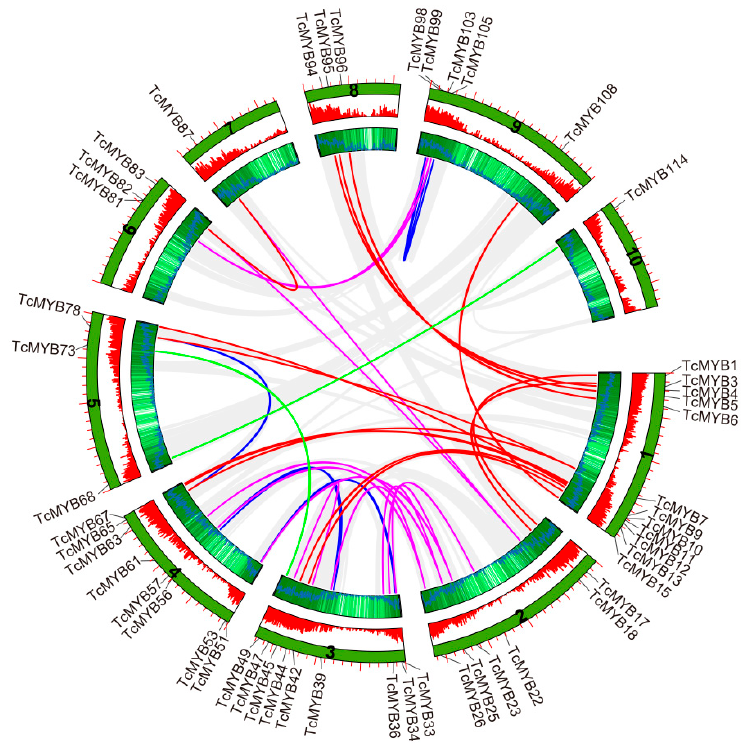
Figure 4. Segmental duplication events of Theobroma cacao R2R3-MYB ( TcMYB ) genes. The 33 putative segmental-duplicated pairs of TcMYB genes are indicated by the colored lines. The putative segmental-duplicated pairs in the Theobroma cacao genome are indicated by the gray lines. The second and third rings from outside represent the density of genes on the chromosomes.